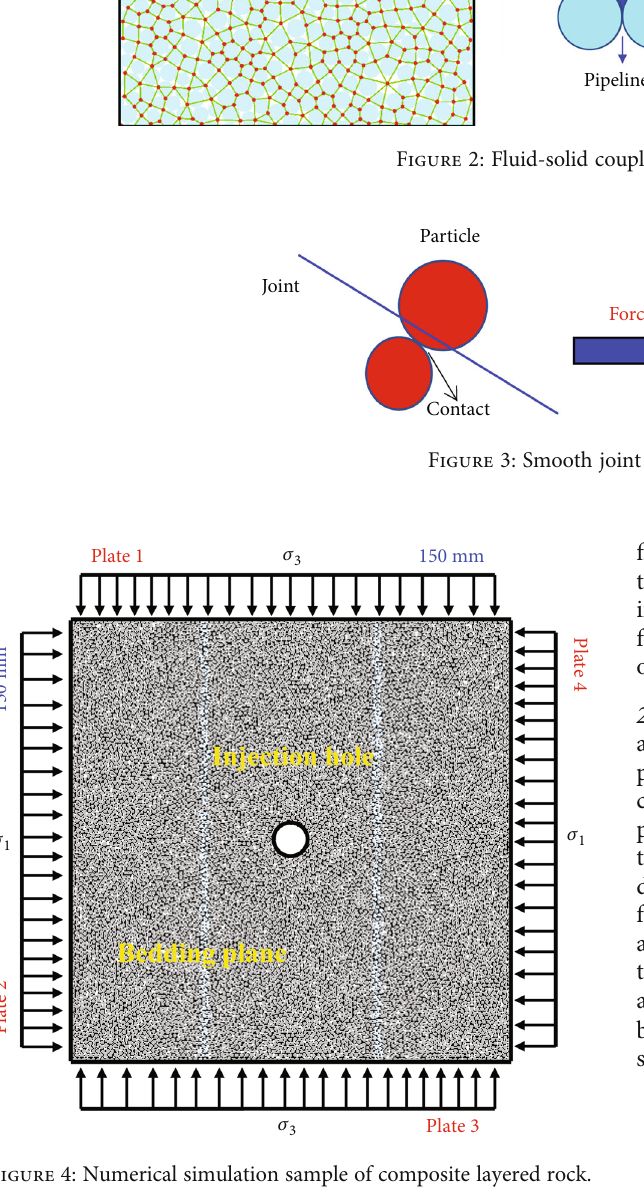
Figure 4: Numerical simulation sample of composite layered rock.